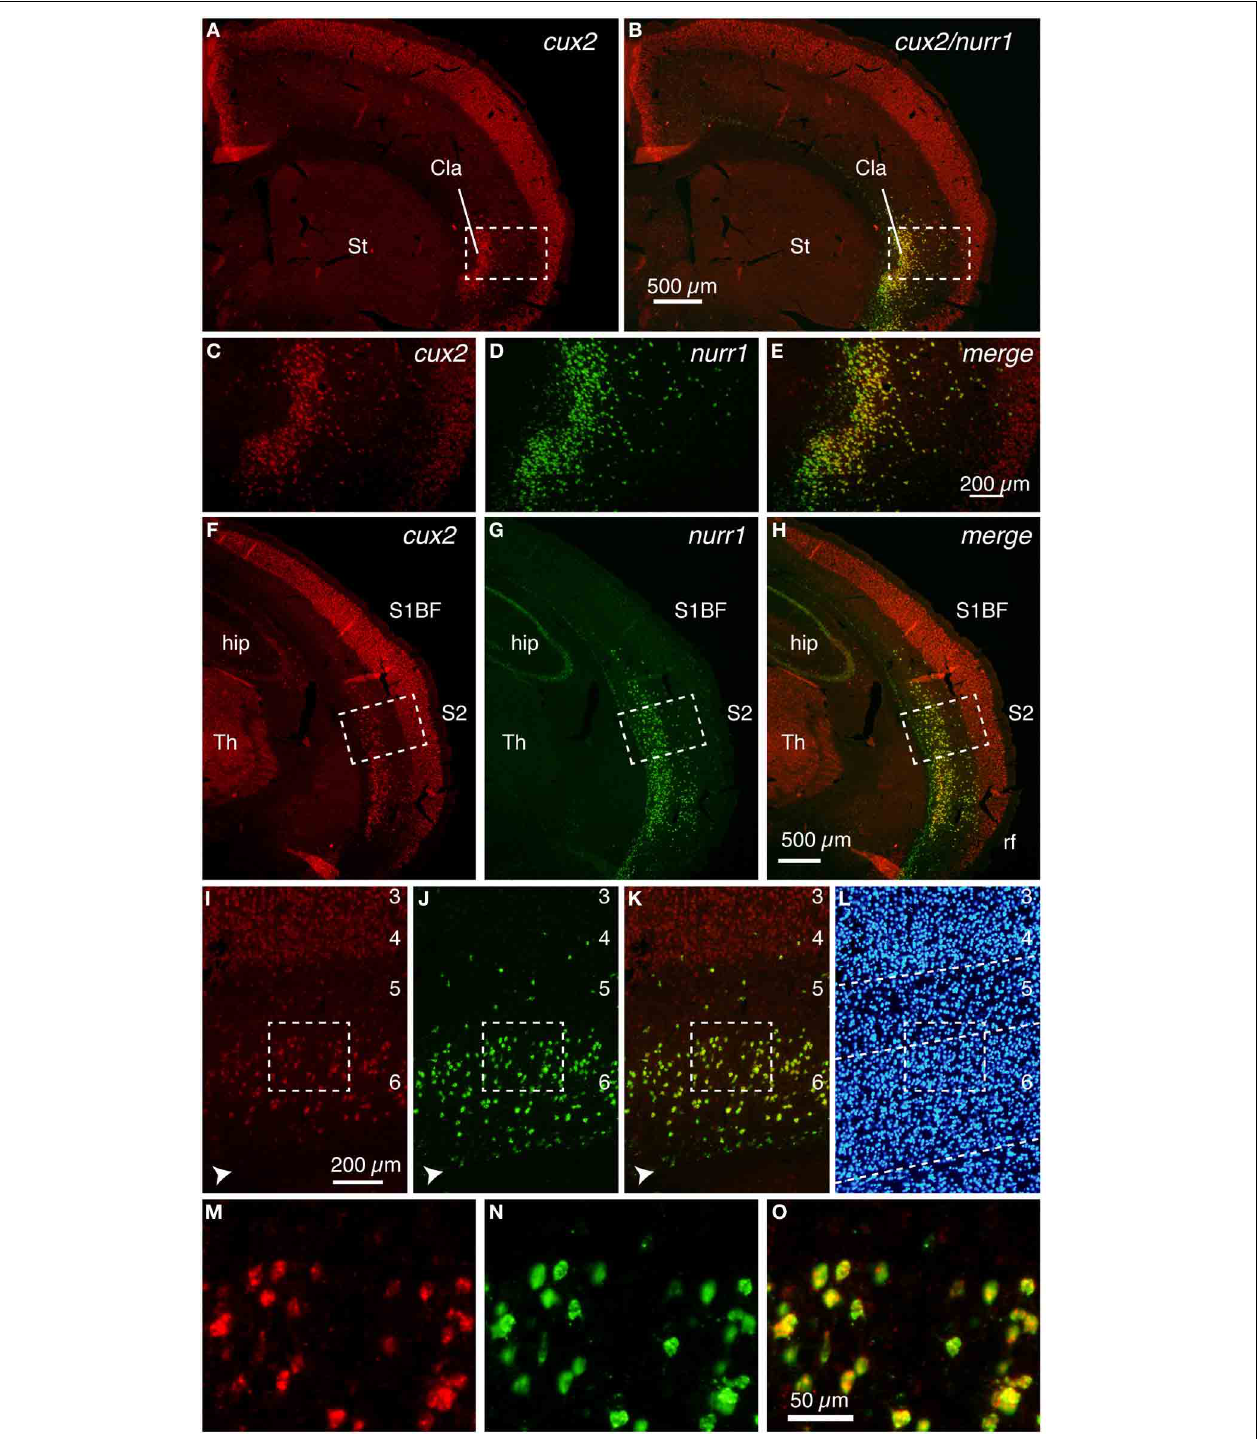
FIGURE 1 | Colocalization of cux2 and nurr1 mRNAs in the claustrum and cortical deep layer of the mouse brain. DIG-labeled cux2 antisense probe (detected in red) and FITC-labeled nurr1 antisense probe (detected in green) were hybridized to the coronal sections of the mouse brain. (A,B) Double ISH of cux2 (red) and nurr1 (green) mRNAs in the frontal section. (A) shows only the red channel (cux2 signal), while (B) shows the merged view